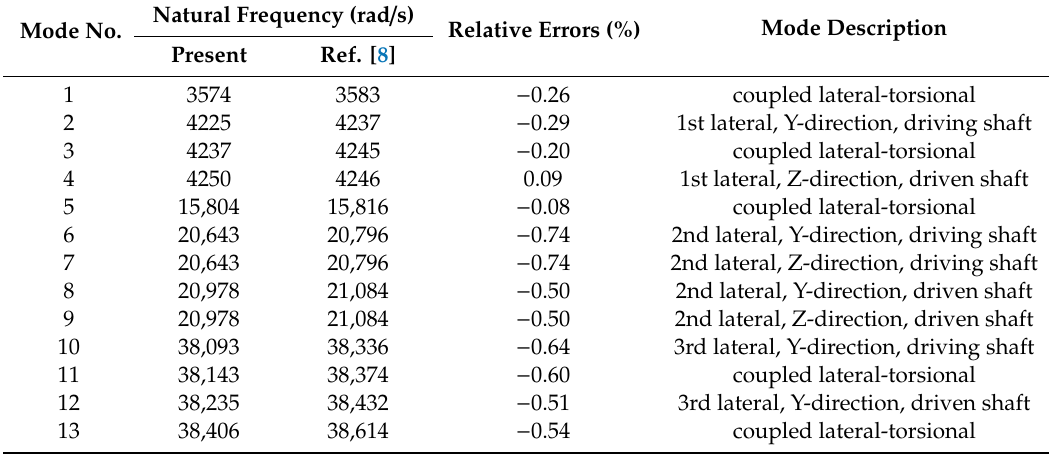
Table 3. Natural frequencies and corresponding mode